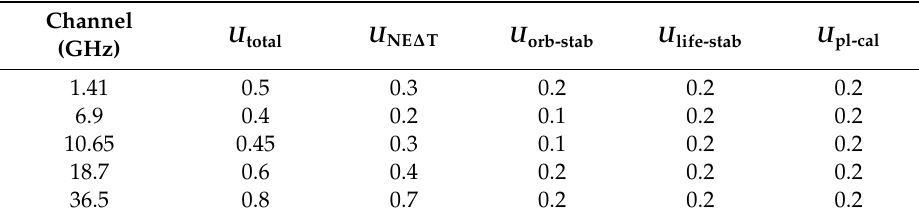
Table 1. Uncertainty components for each of the CIMR channels. The columns give the total uncertainty, as well as the radiometric, orbital stability, lifetime-stability and pre-launch calibration contributions to the total uncertainty